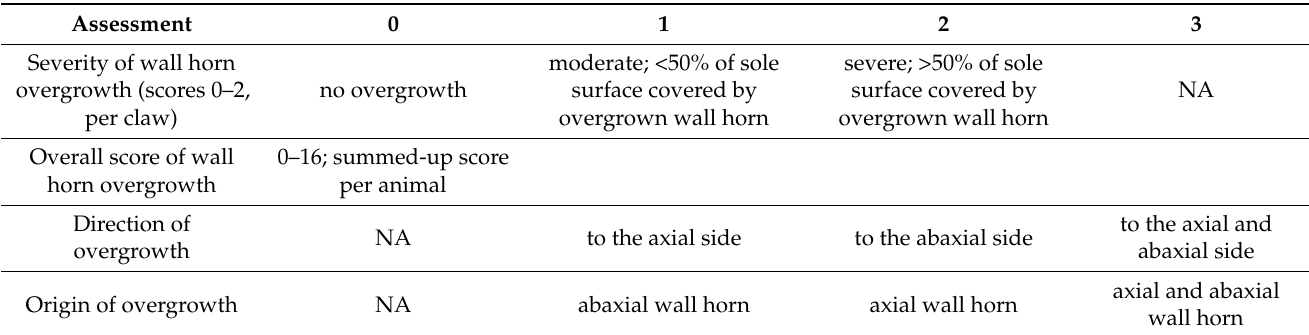
Table 1. Classification of wall horn overgrowth (NA = not